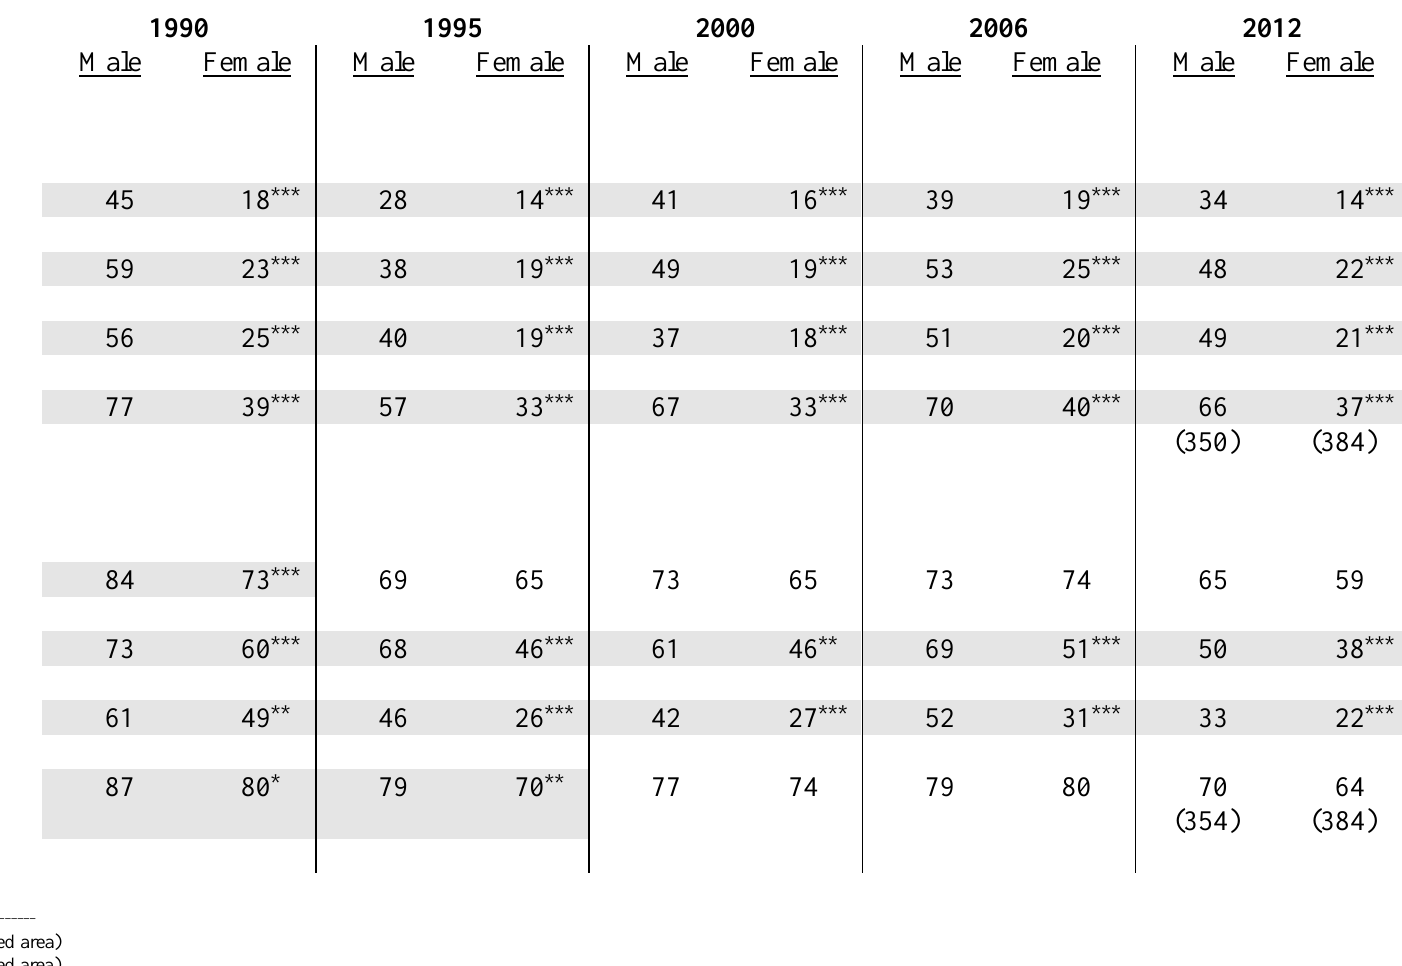
Table 30. Career Aspirations